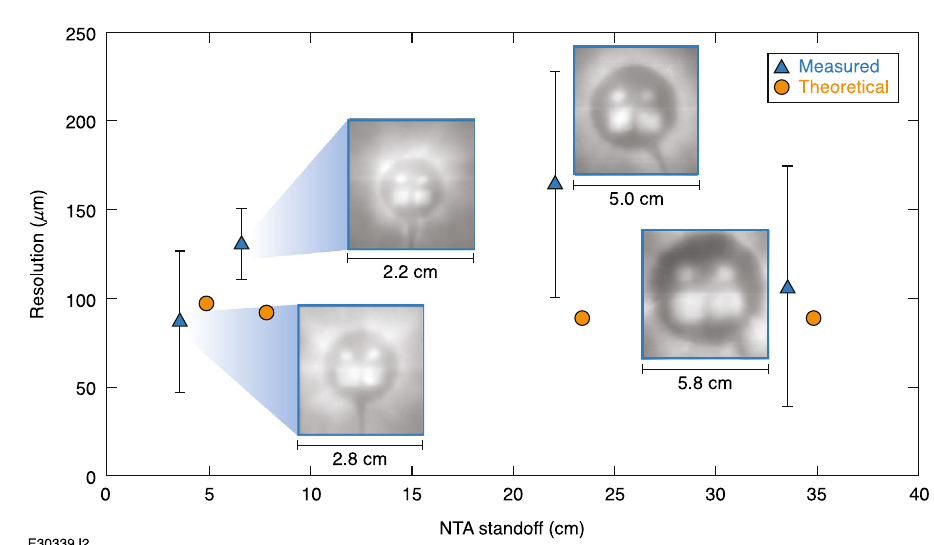
Figure 7. Resolution in the object plane versus imaging distance for tungsten projection radiography objects. Theoretical predictions are calculated using Eq. (3). Each data point has the radiograph recorded on the image plate next to